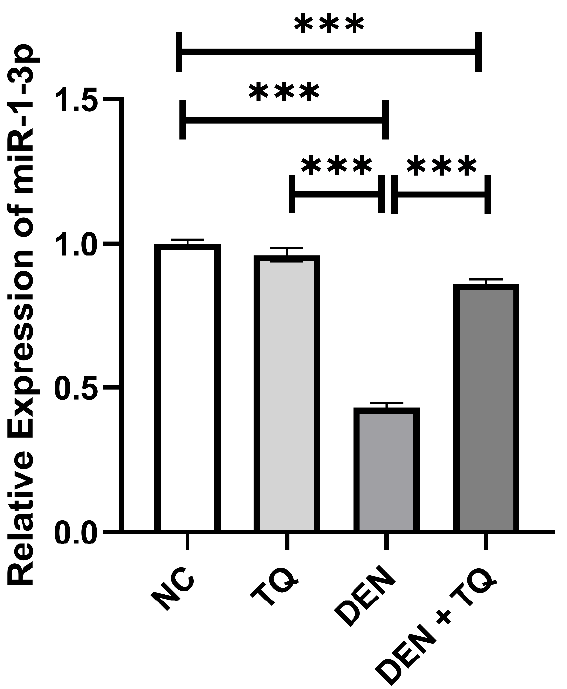
Figure 2. Effect of TQ, DEN, and their combination on miR-1-3p expression in rats’ liver tissue. Pretreatment with TQ restored the miR-1-3p levels compared to the DEN-intoxicated rats. Data are presented as bar charts ( n = 6). *** significant at p < 0.0001.